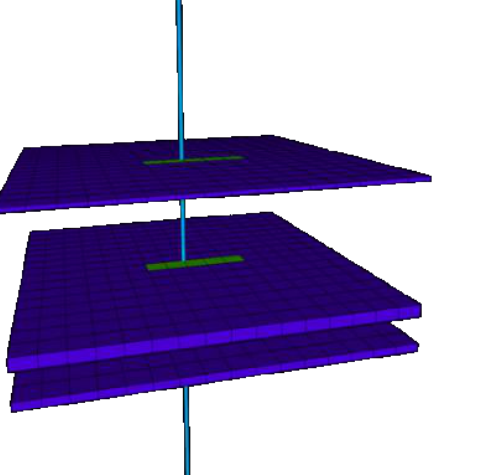
Figure3—Numerical simulation model of reservoir.